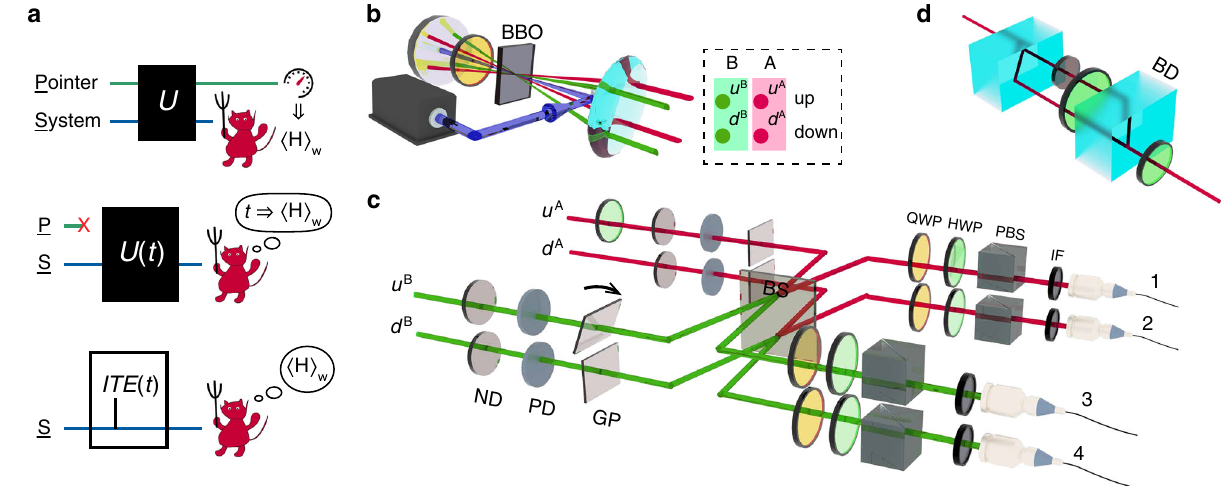
Fig. 2 Design of experiments. a Concept of weak value extraction. Top: rigorous weak measurement. The system and pointer are entangled by coupling (cid:4) P . The demon cast judicious choices of post-selection to obtain the weak value evolution U ¼ exp ð(cid:3) i H t Þ with the interaction Hamiltonian being H ¼ O s O h i U s due to a perturbation is characterised by weak value in the weak w . Mid: interpretation of weak value without pointer. The system's evolution s interaction regime 23 . Bottom: weak value extraction based on perturbation. A linear relationship between the post-selection probability and the interaction time of ITE can be established, whose incline gives the real part of the weak value O h i w . b Photon source. Biphoton (central wavelength 813.4 nm), four- qubit hyperentangled state is generated via type-I spontaneous parametric down-conversion (SPDC) process by pumping a β -barium borate (BBO) crystal twice in a confocal structure 24,25 . CM concave mirror, QWP quarter-wave plate. c The main setup to exchange grins. Neutral density fi lter (ND)